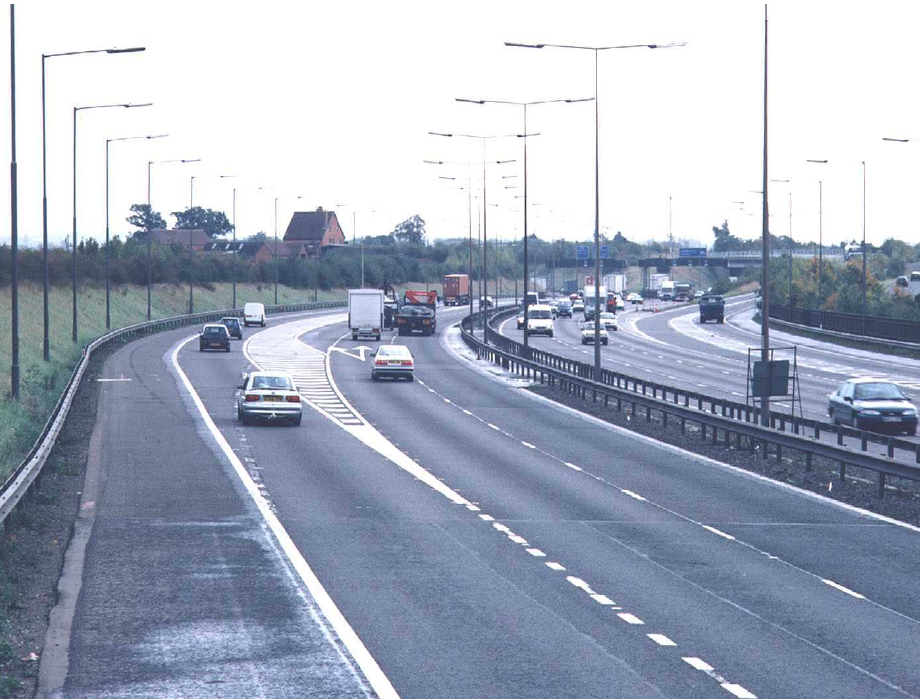
Figure 3. The Ghost Island layout at the M6 junction 4a (from Wedlock et al., 2001) A diverging flow-region diagram is available for use in the UK to help traffic engineers select the most appropriate layout (Taper, Parallel, Taper lane drop, Parallel lane drop